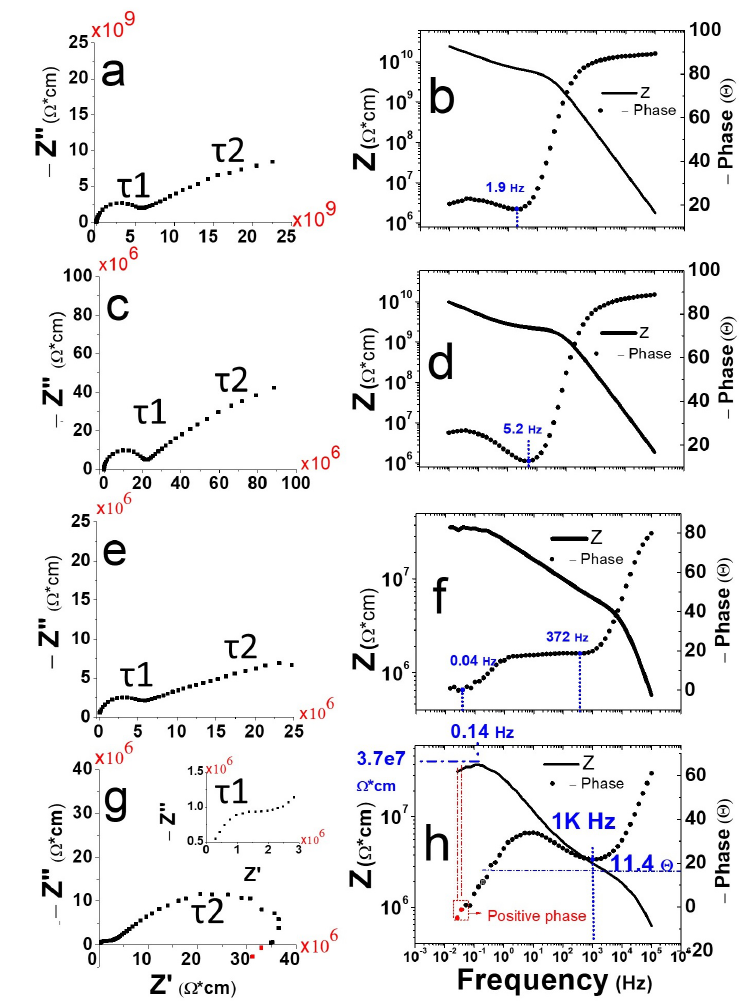
Figure 4. Impedance analysis of pristine porous HCPEG monolithic specimens ( a , b ) and porous HCPEG monolithic loaded with: GNWs (0.4% wt). ( c , d ), PANI (0.8% wt) ( e , f ) and PANI (0.8% wt) + GNWs (0.4% wt) ( g , h